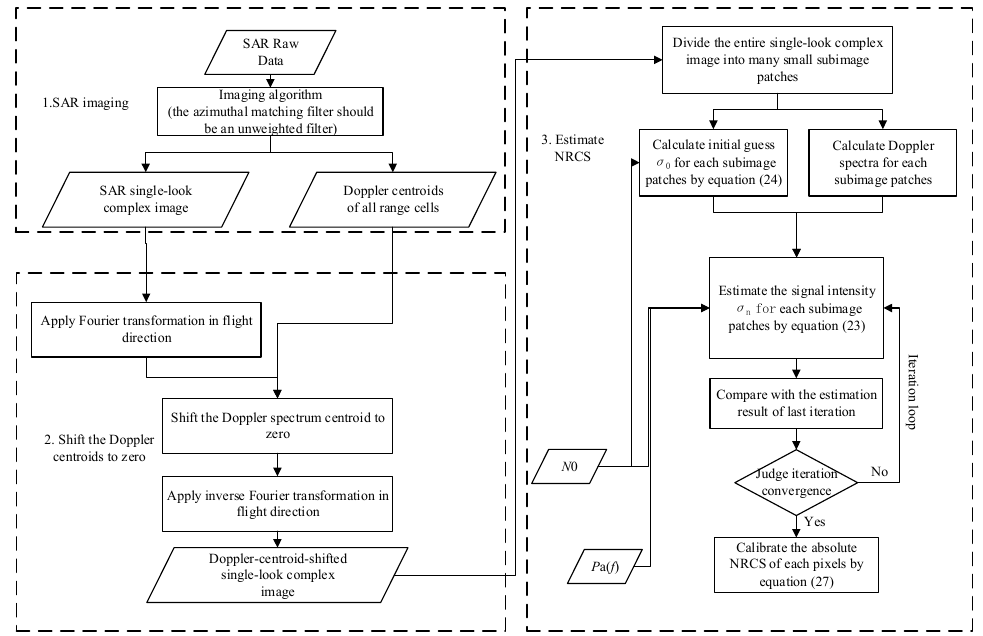
Figure 2. Algorithm flow chart.